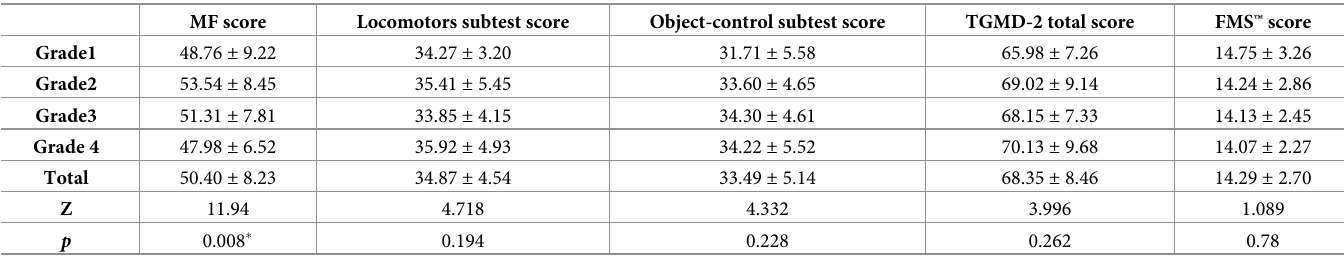
Table 3. Age-specific analyses of MF test, TGMD-2, and FMS ™ (mean ± SD).